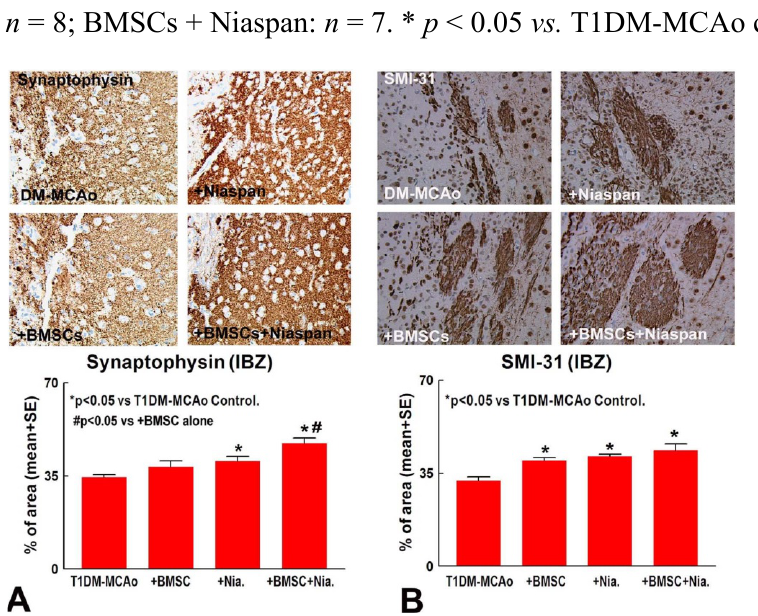
Figure 2. Treatment of stroke with BMSCs, Niaspan and combination BMSCs+Niaspan